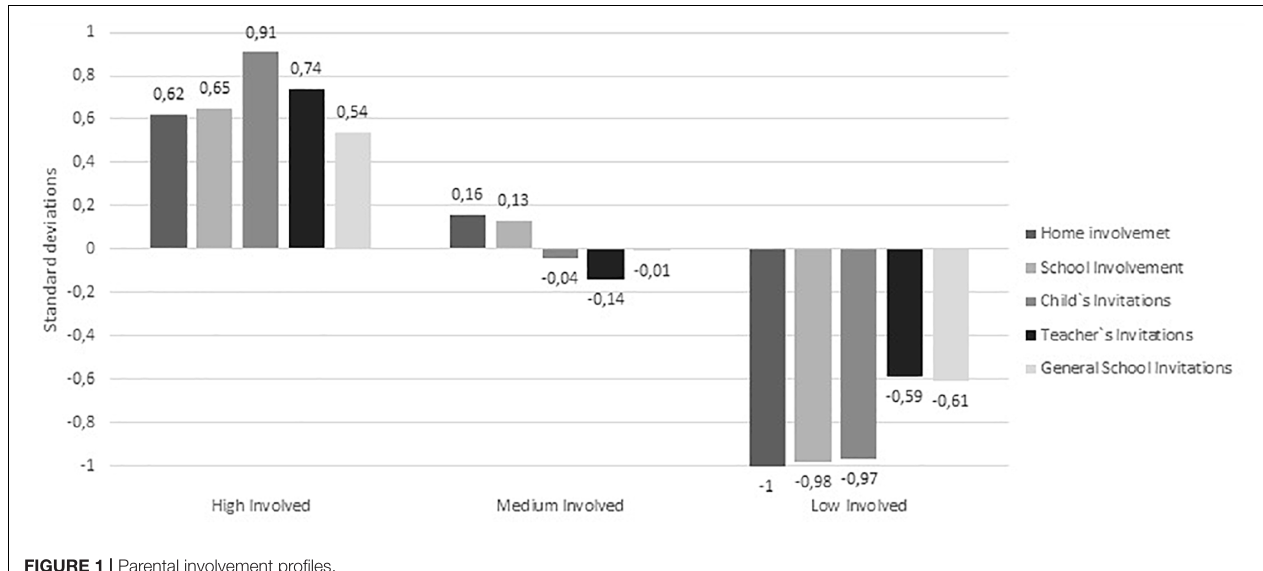
FIGURE 1 | Parental involvement profiles.